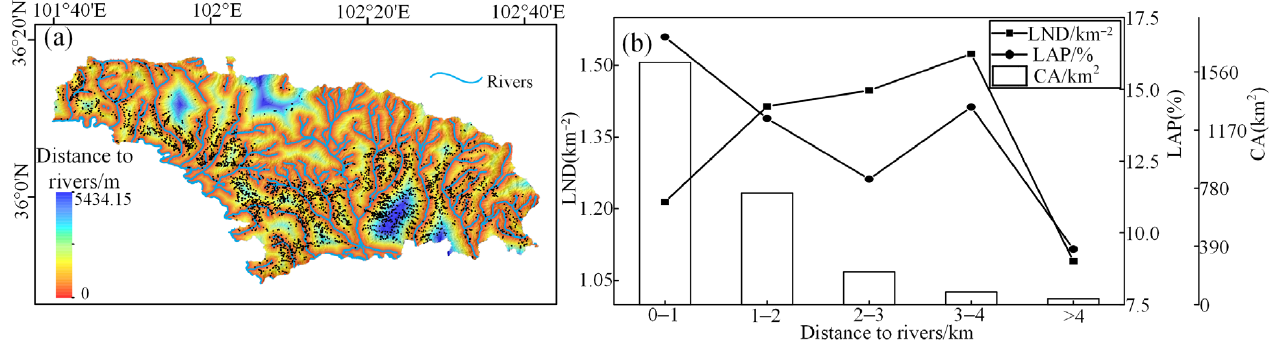
Figure 15. Relationship between the distance from rivers and the landslide distribution. ( a ) The distribution of the distance from rivers in the study area. ( b ) Statistics of landslide indicators in the intervals of the distance from rivers.